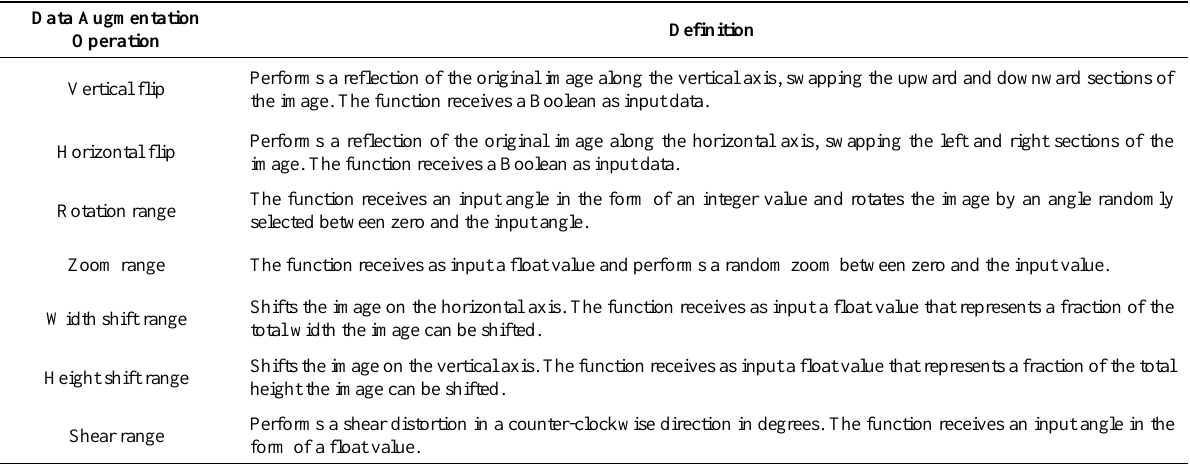
Table 3. Definition of the Data Augmentation